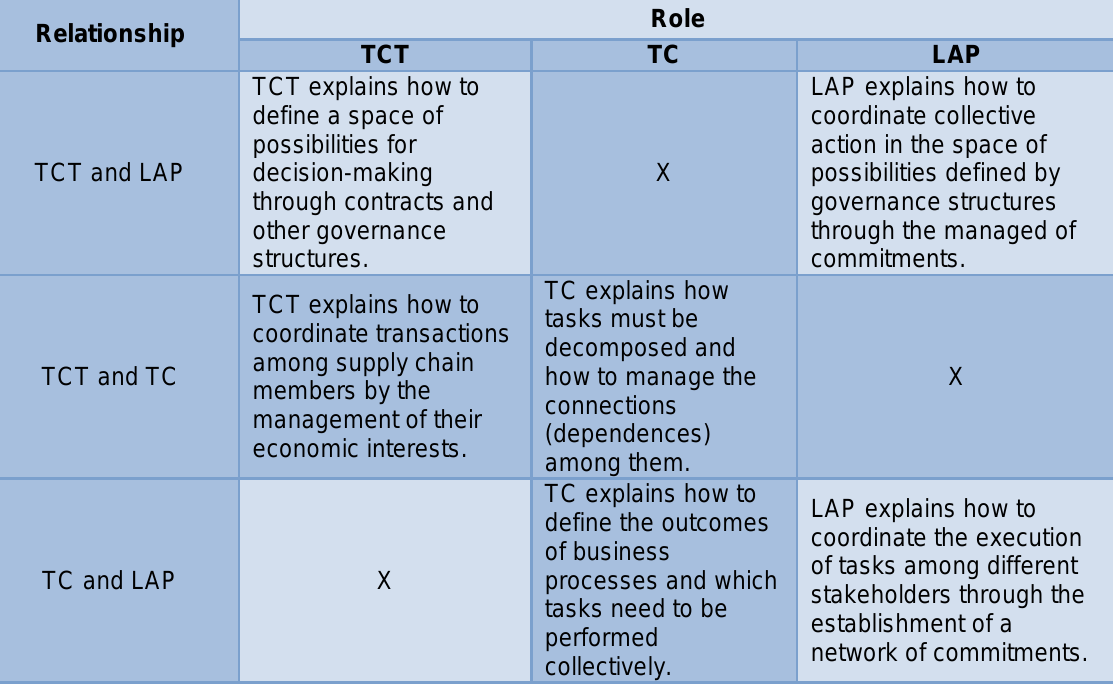
Table 10 Complementarities between TC, TCT and